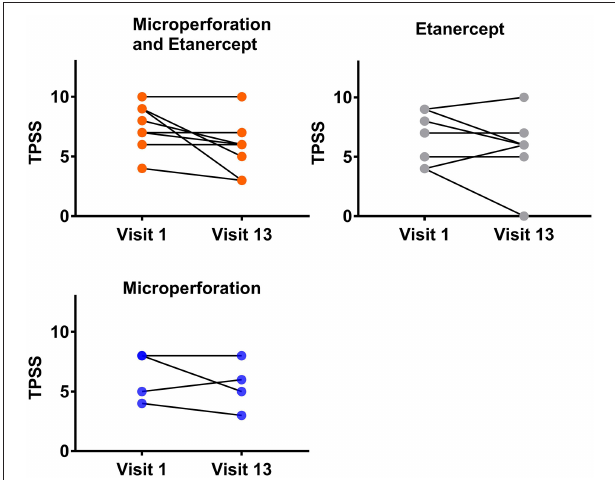
FIGURE 1 | TPSS values (mean ± SD). TPSS was assessed before the respective twice weekly treatments [Er:YAG laser microporation, etanercept (ETA) or combination] over the 6 week study period.